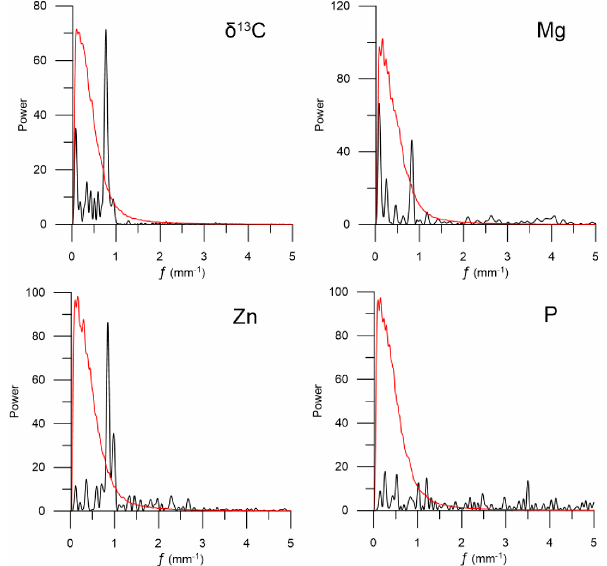
Figure 6. Periodograms (FFT) of δ 13 C, Mg, Zn and P measured in P16 to illustrate how the quality of a proxy to record the seasonal cycle can be studied. The red line represents the 95% confidence level. δ 13 C is taken as a reference. The periodograms include two examples of proxies with a distinct peak in the seasonal frequency band of 0.8mm − 1 (Mg and Zn) and one proxy with no peak (P) in the seasonal frequency band. Periodograms for all periods are provided in the Supplement.